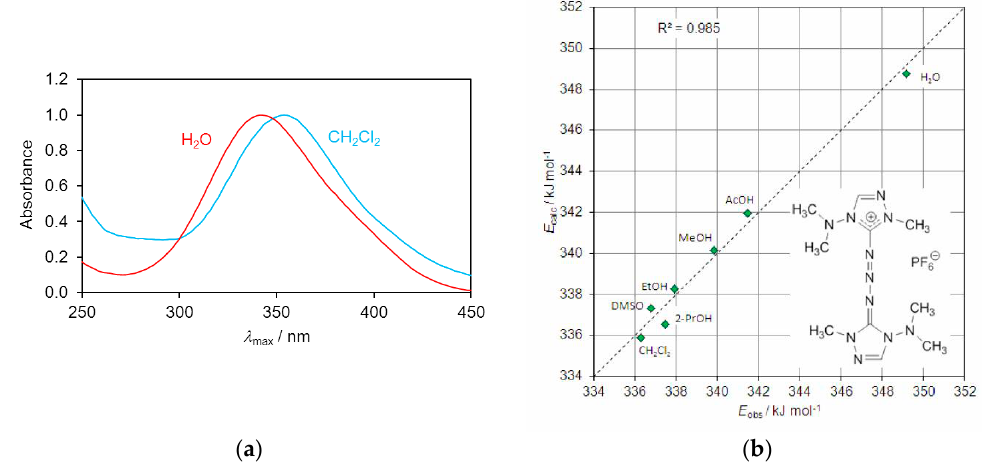
Figure 5. ( a ) Normalized UV spectra of triazene 3 in H 2 O and CH 2 Cl 2 ; ( b ) Correlation of observed vs. calculated UV transition energies of triazene 3 in seven polar solvents.